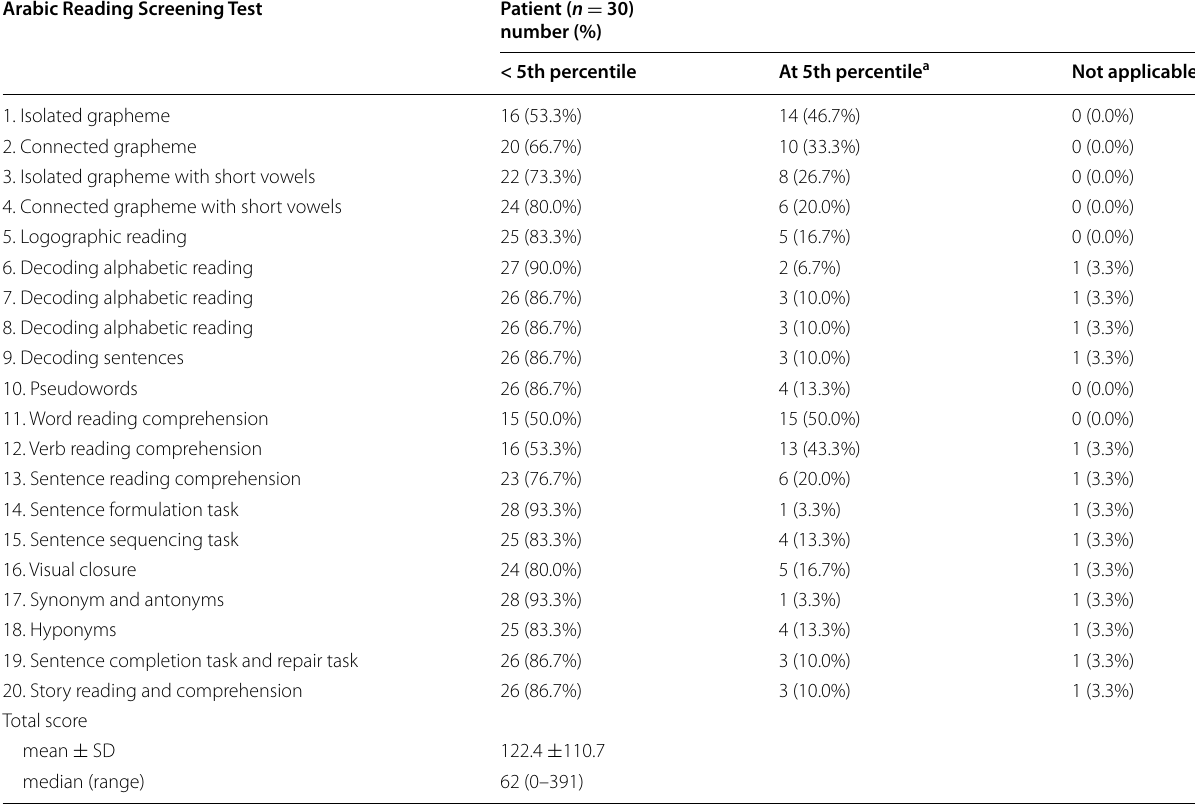
Table 3 Results of the Arabic Reading Screening Test scores Arabic Reading Screening Test